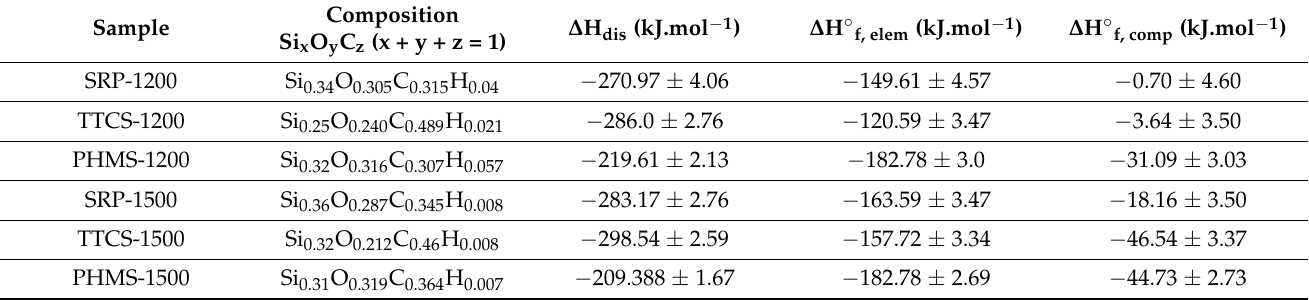
Table 7. Summary of thermodynamic analysis using Si-corrected (H included) compositions from combustion analysis, plus C and O content as average of XPS and combustion